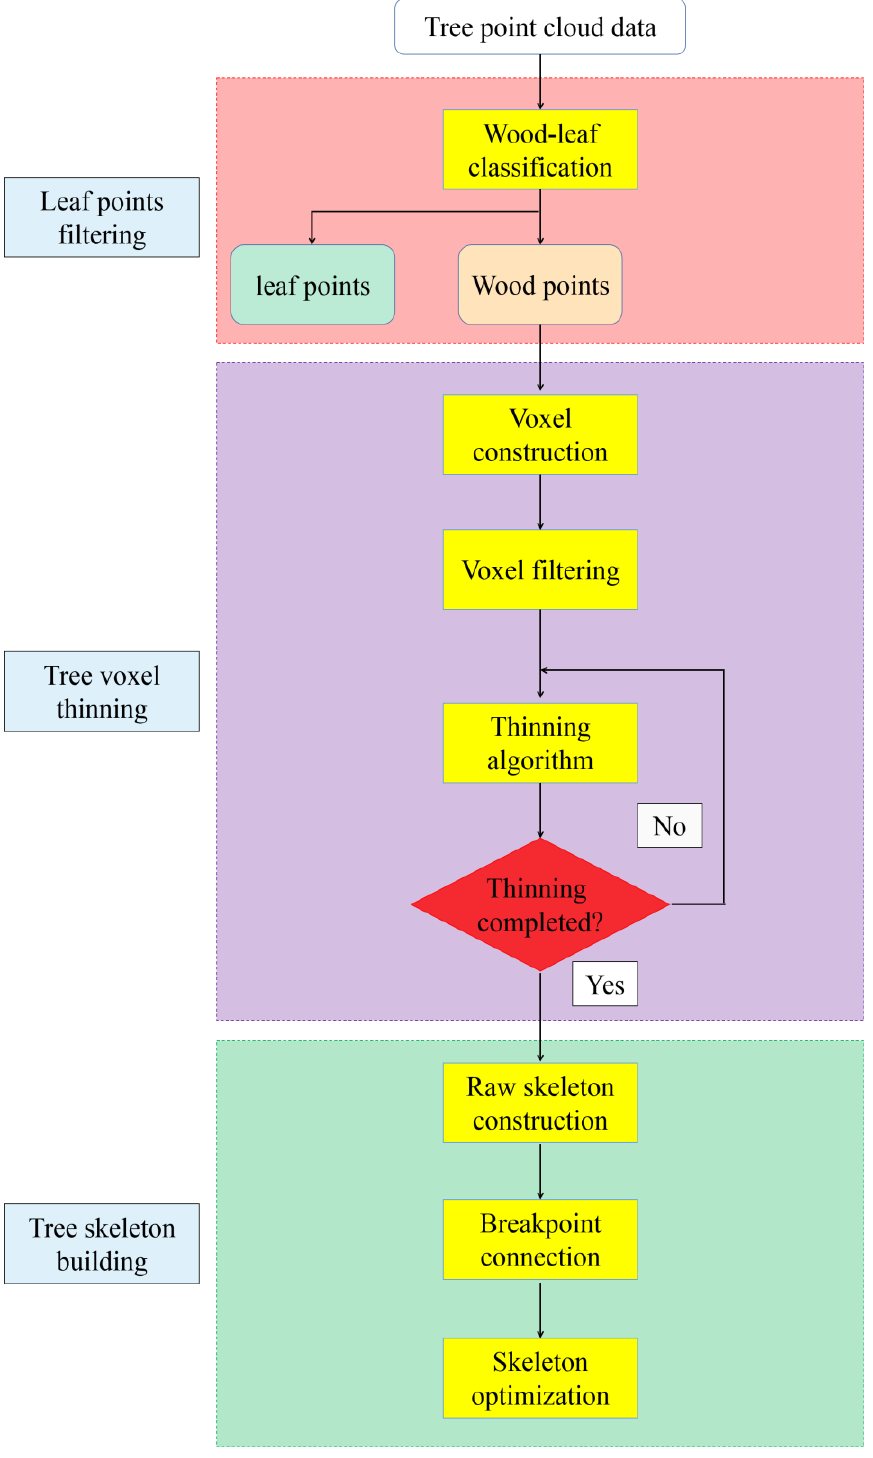
Figure 1. Flow chart of the FTSEM algorithm.